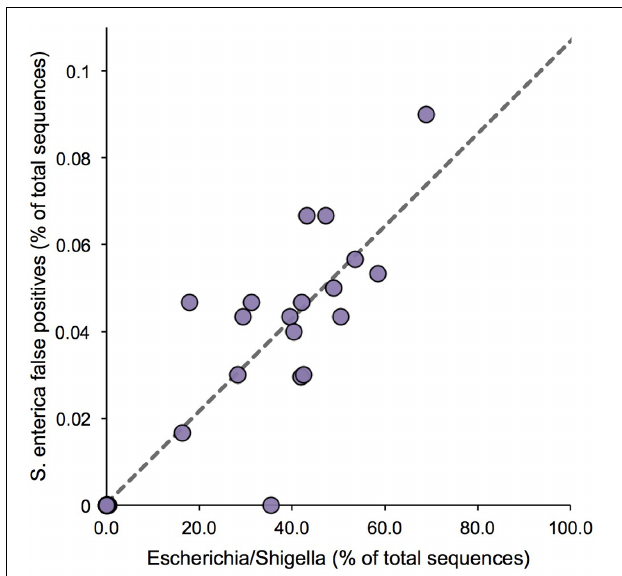
FIGURE 2 | False positive assignments to Salmonella for Resphera Insight. Sequencing of spiked samples of raw cheese milk demonstrates a positive correlation between Escherichia / Shigella abundance and false positives assignments to S. enterica . Linear regression (dashed line) estimates a maximum predicted S. enterica false positive rate of 0.11%.